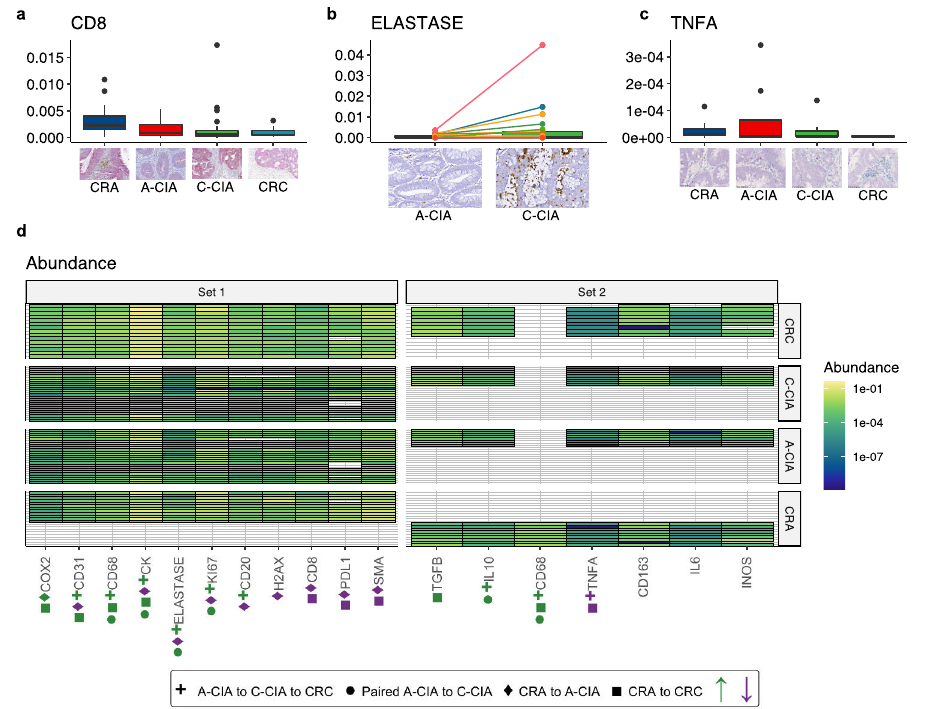
Fig. 5 Signi fi cant changes in average cell type abundance and cytokine expression pro fi les show that immunosuppressive niche engineering is observed early at the progressed adenoma (A-CIA) stage and continues through colorectal carcinoma (CRC). In a – c , the center line of each boxplot indicates the median, the top and bottom of the box indicate the 75th and 25th percentiles, respectively, the top whisker the largest value that is no further than 1.5 interquartile range (IQR) from the 75th percentile, the bottom whisker the smallest value no more than 1.5 IQR from the 25th percentile, and points indicate outliers. In addition to showing the distribution of abundances, we also provide histological examples of differences in abundance/gene expression in each category. Results shown in a , b and Set 1 in d are based on n = 12 independent colorectal adenomas (CRA), n = 25 independent A-CIA, n = 26 independent early carcinomas (C-CIA), and n = 15 independent CRC. Results in c and Set 2 in d are based on comparing n = 9 independent CRA, n = 8 independent A-CIA, n = 9 independent C-CIA, and n = 9 independent CRC. a Benign adenomas (CRA) have signi fi cantly higher cytotoxic T cell abundances than A-CIA or carcinomas (CRC). b Changes that accompany the transition from adenoma to carcinoma were revealed using paired tests to directly compare adenomas (A-CIA) to their descendant carcinomas (C-CIA). Here, we show the signi fi cant increase in neutrophils from each A-CIA to its descendant C-CIA. c Expression of the in fl ammatory cytokine TNF- α (red) signi fi cantly decreased during progression from progressed adenoma (A-CIA) to early carcinoma (C-CIA) to malignancy (CRC), culminating in CRC having signi fi cantly less TNF- α , and more immunosuppressive TGF- β (blue) than benign adenomas (CRA). d Table showing the abundance of each marker (columns) for each sample (rows). Shapes below each marker signify that there were signi fi cant changes in abundances across the speci fi ed group. Green indicates that the marker increased from the fi rst group to the last group, while purple indicates that the abundances decreased. These results are based on a suite of statistical tests. Please see Supplemental Fig. 7 for p values. Examination of changes in cell and cytokine abundances reveal that, among other things, there is a signi fi cant decrease in the abundance of cytotoxic T cells from benign adenoma (CRA) to adenomas that progressed (A-CIA) (purple diamond). Paired tests reveal that when directly compared to their ancestral adenoma (A-CIA), carcinomas (C-CIA) have signi fi cant increases in the abundance of macrophages (CD68), neutrophils (elastase), and cytokine IL-10, all of which can be associated with immune suppression. These trends are also observed when quantifying changes from late adenoma (A-CIA) to nascent carcinoma (C-CIA) to mature carcinoma (CRC), along with additional increases in B cells (CD20) and vasculature (CD31), and accompanied by a decrease in the in fl ammatory cytokine TNF- α . Together, these patterns indicate that during the evolution of a malignant tumor, the engineering of an immunosuppressive ecology begins early in the adenoma stage, and continues through to malignant CRC graph of average positive associations and the second graph of average negative associations) 52,53 .